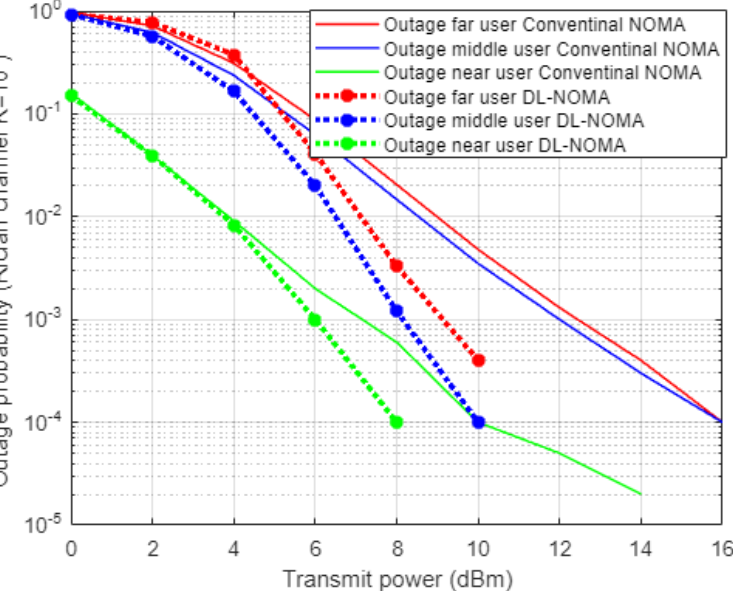
Figure 9. Outage probability vs. power-based DL and conventional NOMA (Rician channel).